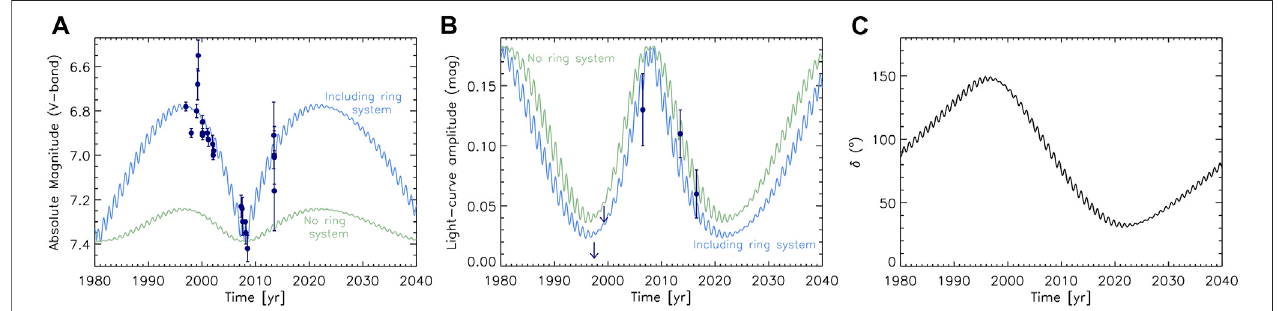
FIGURE2| ComparisonofChariklo ’ smodelswith(bluelines)andwithout(greenlines)theringsystemfortheabsolutemagnitude (A) ,addaptedfromDuffardetal. (2014),andtheamplitudeoftherotationallight-curve (B) .Darkbluecirclesandarrows(upperlimits)representobservationaldatafromtheliterature,Duffardetal.(2014), andreferencesthereinforpanel (A) ;andDaviesetal.(1998);Peixinhoetal.(2001);Galiazzoetal.(2016);Fornasieretal.(2014);Leivaetal.(2017)forpanel (B) .Panel (C) provides the aspect angle of Chariklo over one orbital